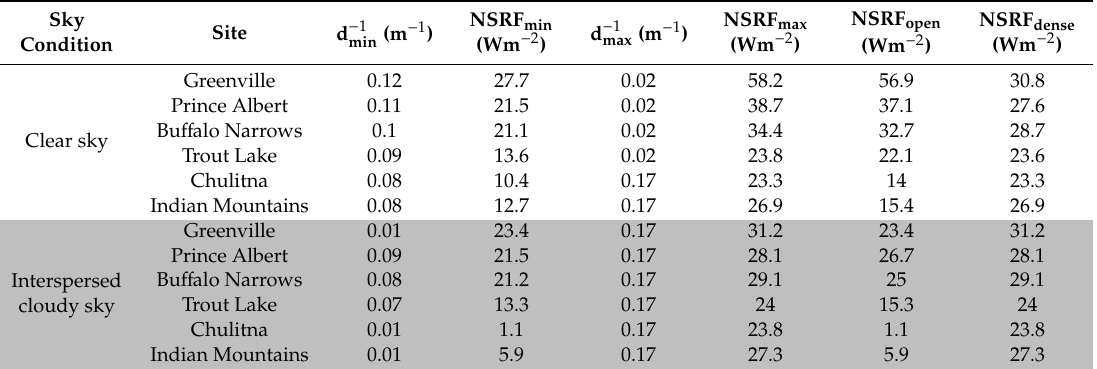
Table 3. Minimum and maximum net radiation compared to radiation in open (NSRF open ) and very dense (NSRF dense ) areas for level forests at di ff erent